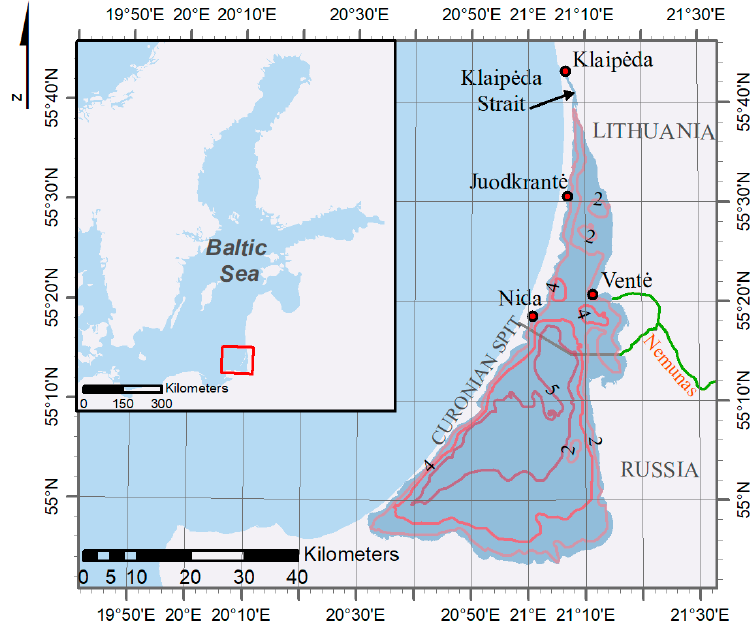
Figure 1. Location of the study area–the Curonian Lagoon, with respect to the Baltic Sea. The red frame in the smaller map shows the location of the lagoon in the southeastern part of the Baltic Sea, while the red points indicate the locations of the coastal stations. The contour lines inside the lagoon indicate the bathymetry.